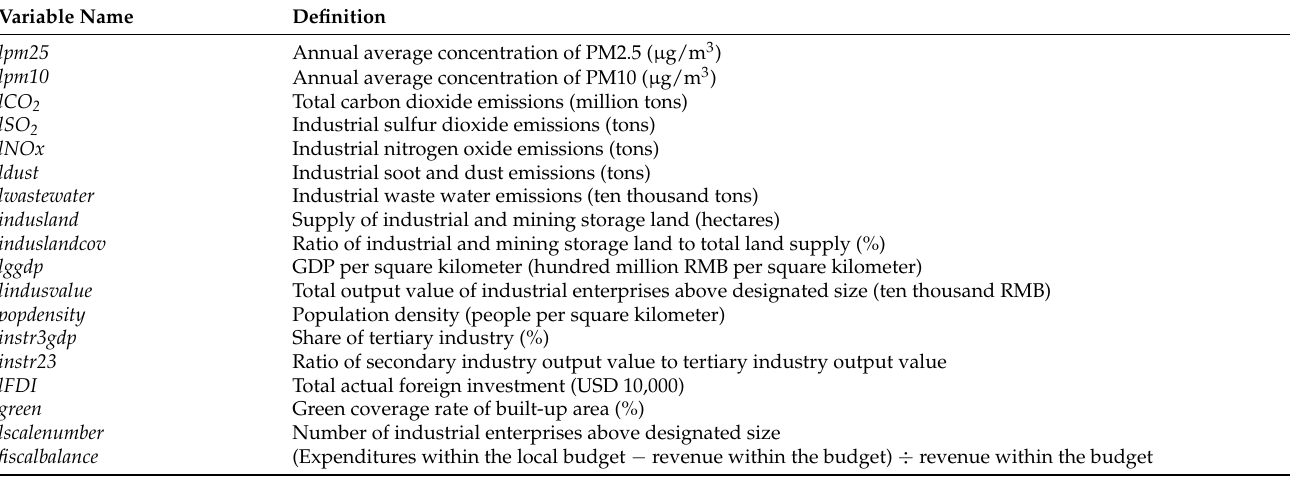
Table 1. Variable